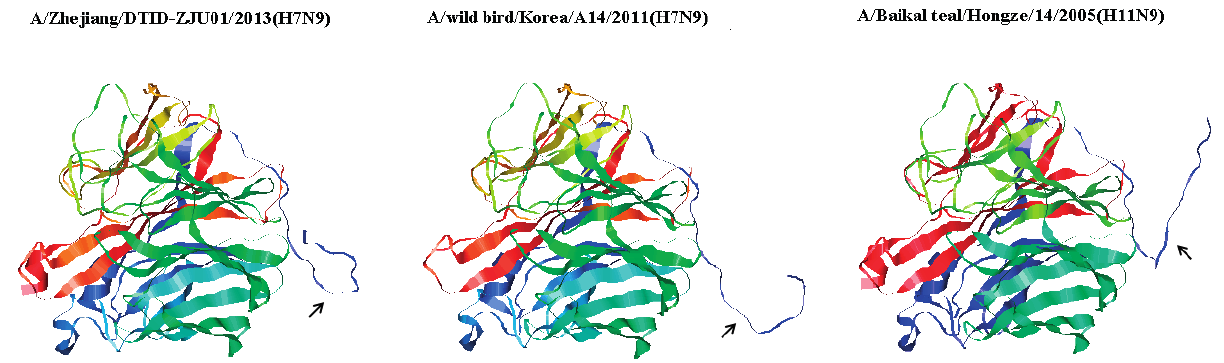
Figure 3. Tertiary structures of neuraminidase affiliated to novel AIV H7N9 and its ancestors. Compared with two ancestors, novel AIV H7N9 with deletion in its neuraminidase stalk had a more compact spatial structure. The deletion and its corresponding regions in neuraminidase stalk of novel AIV H7N9 and its ancestors are pointed by